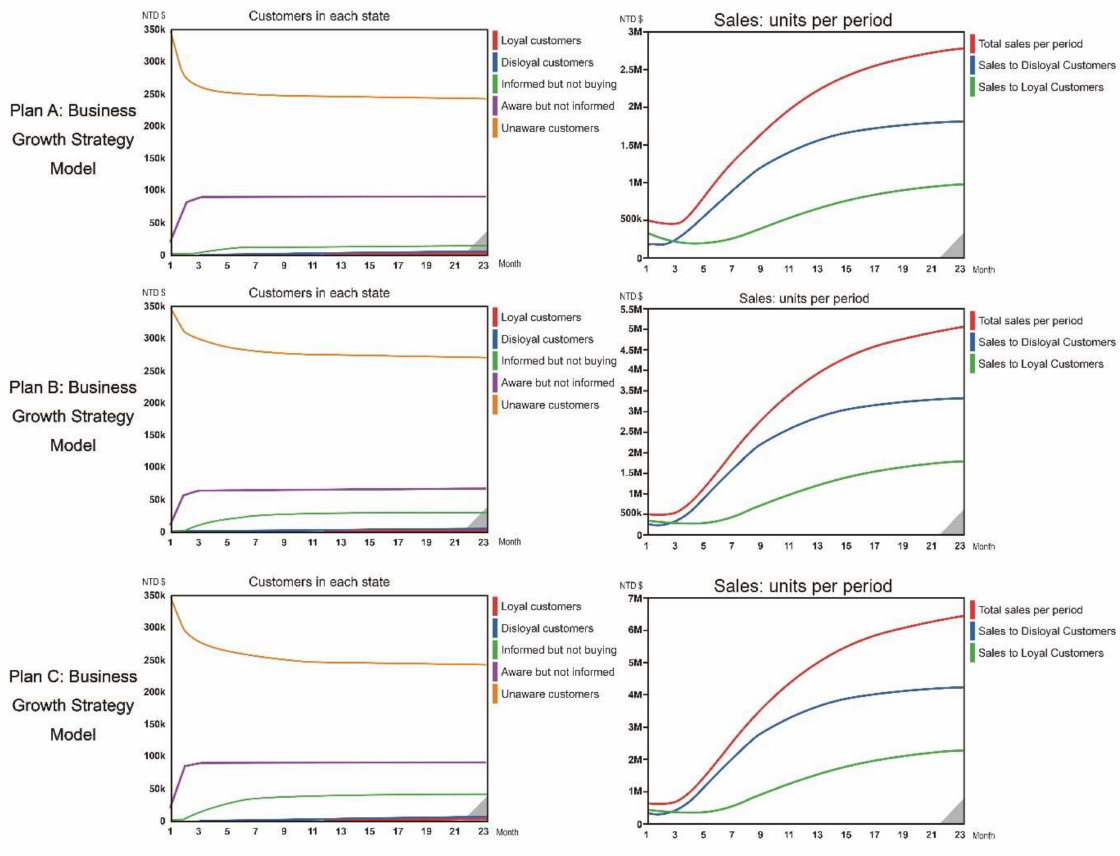
Figure 4. Simulated results and key performance comparison of different